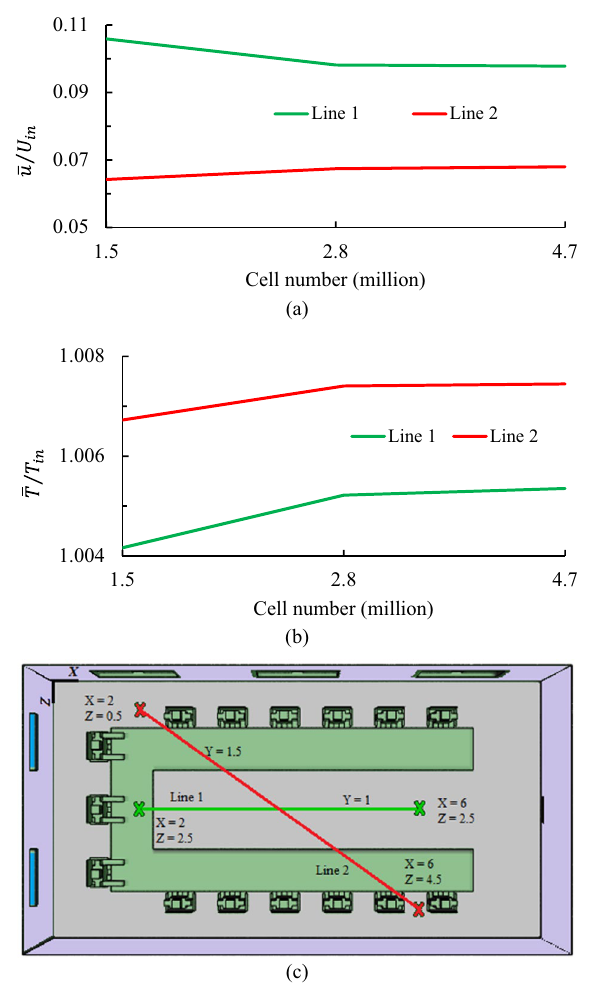
Figure 4. Grid sensitivity analysis for dimensionless: ( a ) airflow velocity ( u / U in ), and ( b ) airflow temperature ( T / T in ); ( c ) location of the investigated lines inside the